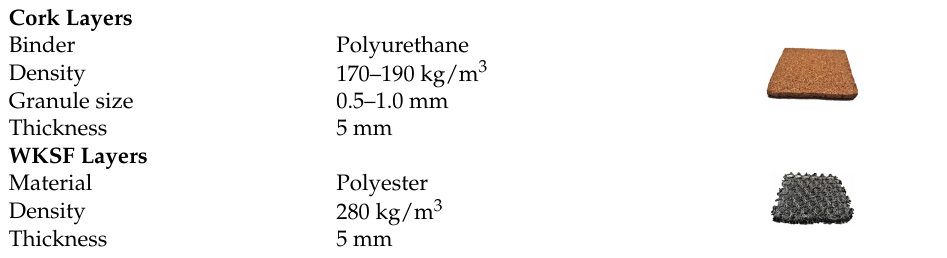
Table 1. Details of the